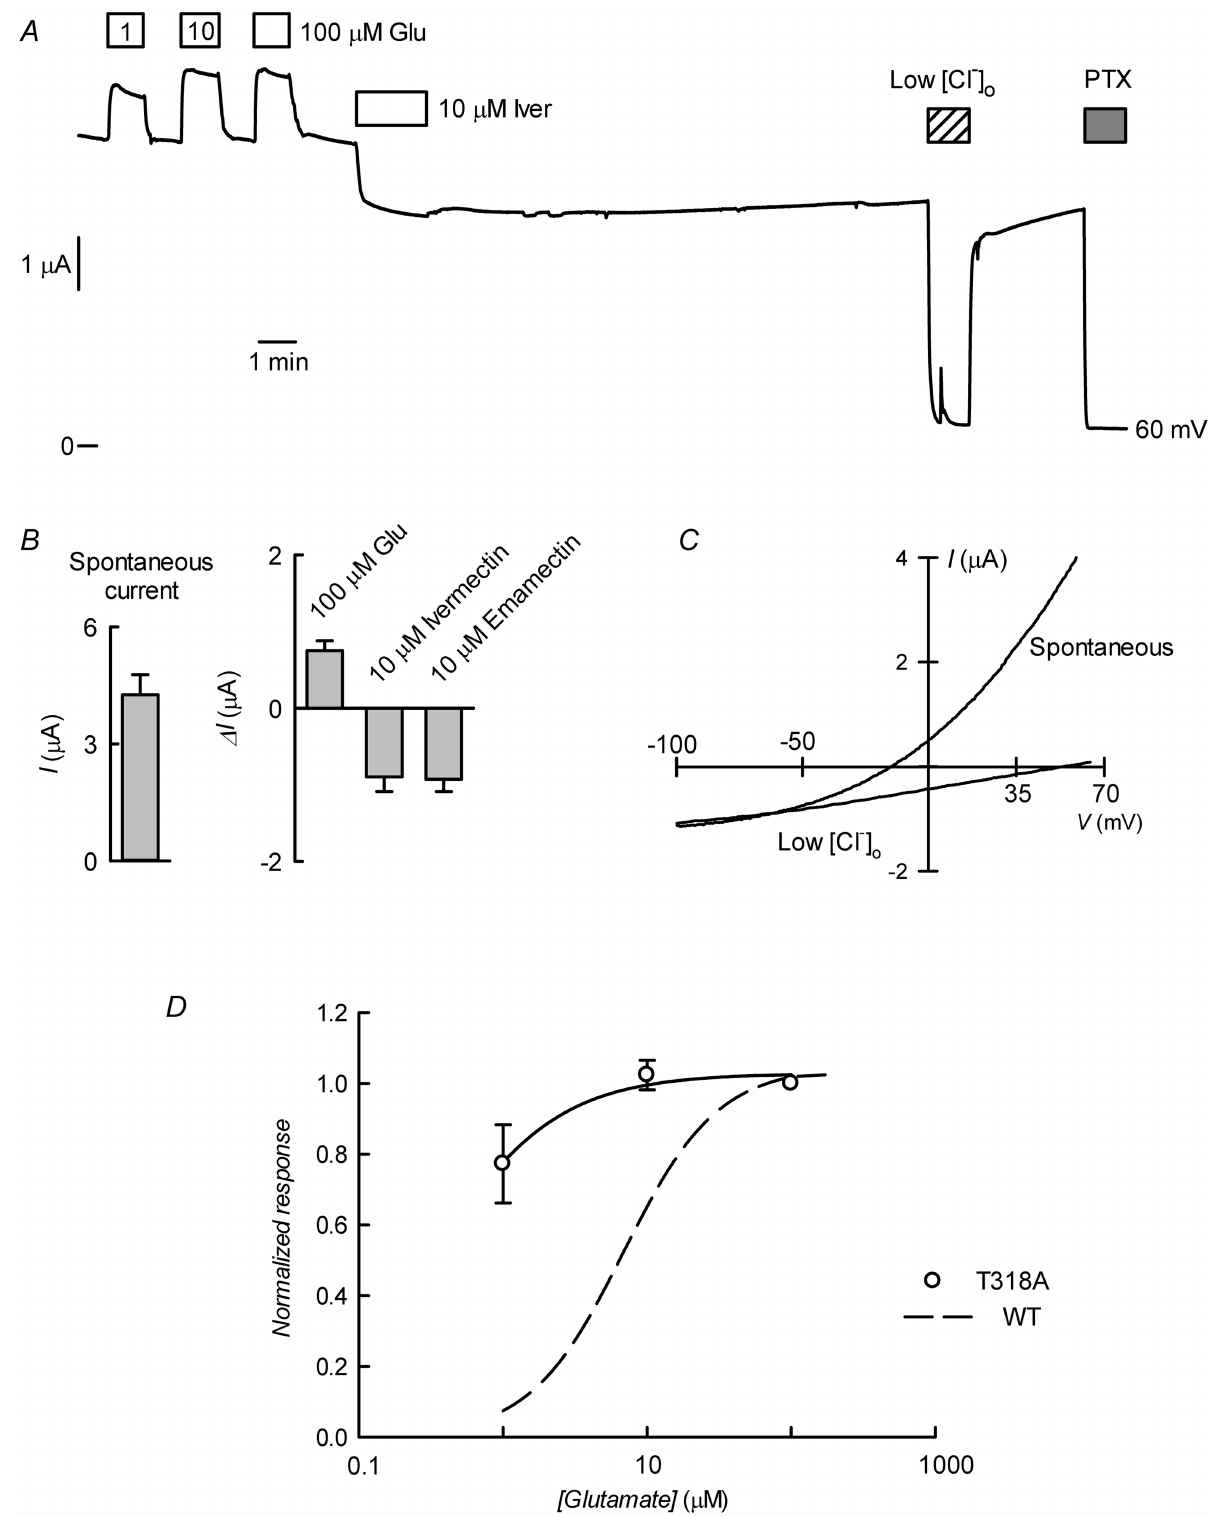
Figure 9. CrGluCl-T318A expression in Xenopus oocytes. A. Current trace obtained in a CrGluCl a -T318A-expressing oocyte that exhibited high spontaneous current at the indicated membrane potential. Bath application of glutamate at concentrations from 1 to 100 m M took place during the times shown in the boxes. This was followed by exposure to ivermectin, decrease of bath [Cl 2 ] to 7.6 mM and addition of 100 m M PTX. B. Average with SEM of spontaneous currents in CrGluCl a -T318A-expressing oocytes (n=7), and increase in current evoked by 100 m M glutamate (n=7), and the current decrease upon addition of ivermectin (n=4) or emamectin (n=5). C. Current voltage relations of spontaneous current exhibited in a CrGluCl a -T318A-injected oocyte in normal bath solution and after all but 7.6 mM extracellular Cl 2 was replaced by gluconate. The current-voltage